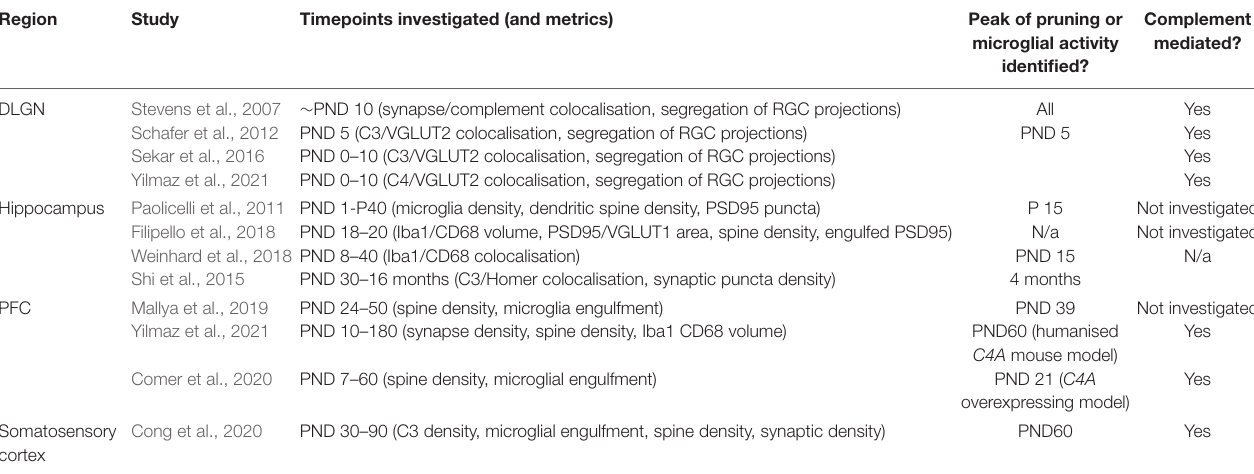
TABLE 1 | Estimated time course of microglia and/or complement dependent synaptic pruning in different brain regions.